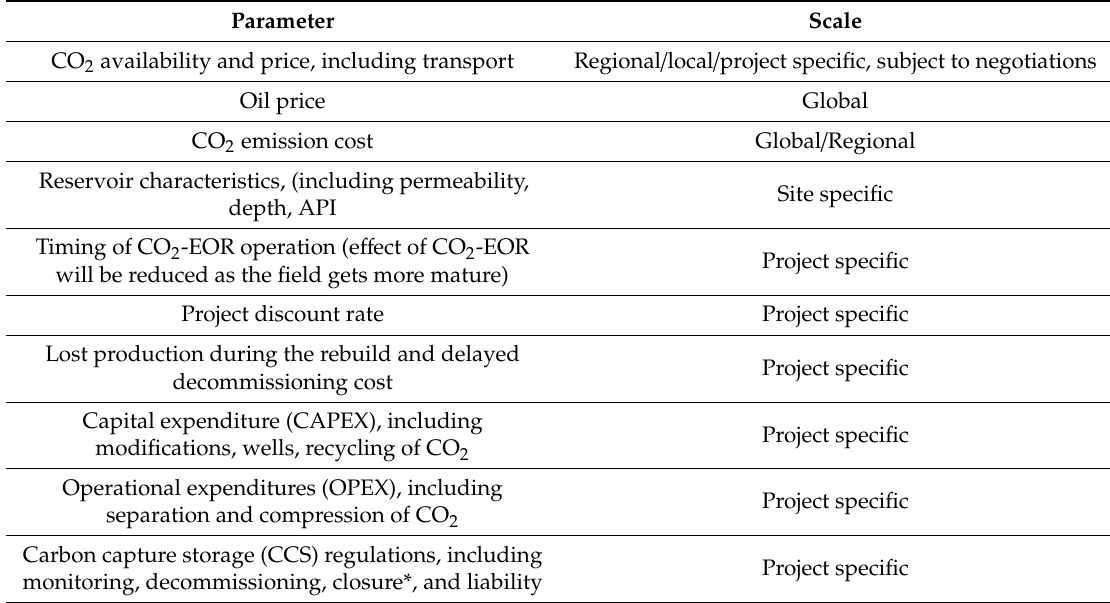
Table 2. Some key input parameters to CO 2 -EOR profitability studies and their relevant scales.